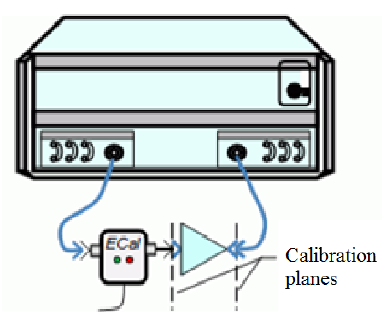
Fig. 11. Noise figure measurements by using MICRAN